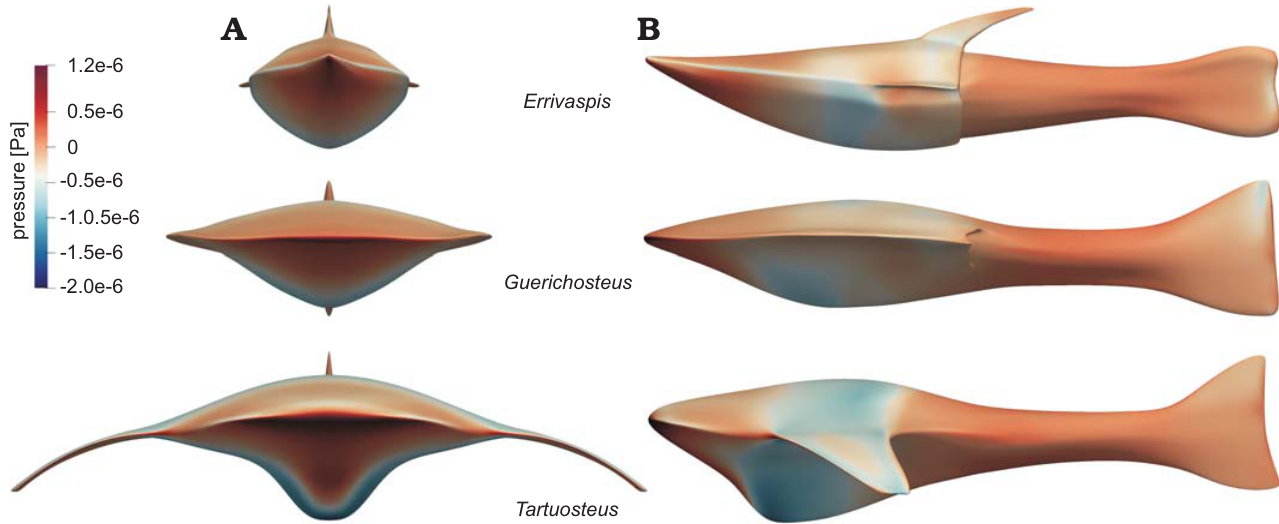
Fig. 2. Distribution of pressure on the fish bodies at flow velocity 1.5 ms -1 , in anterior (A